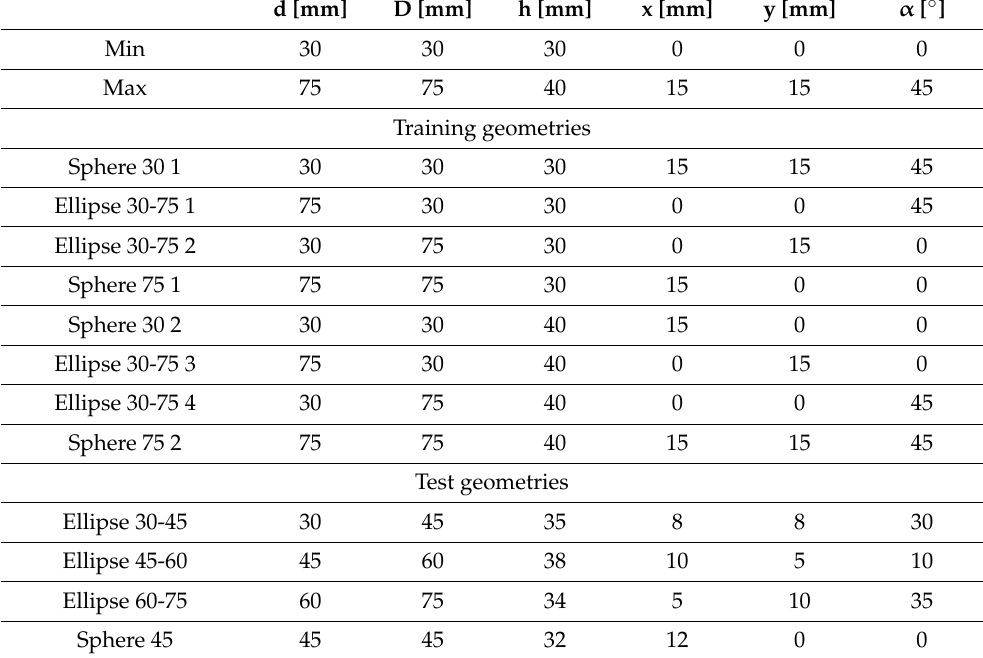
Table 3. Ellipsoid training and test set workpiece